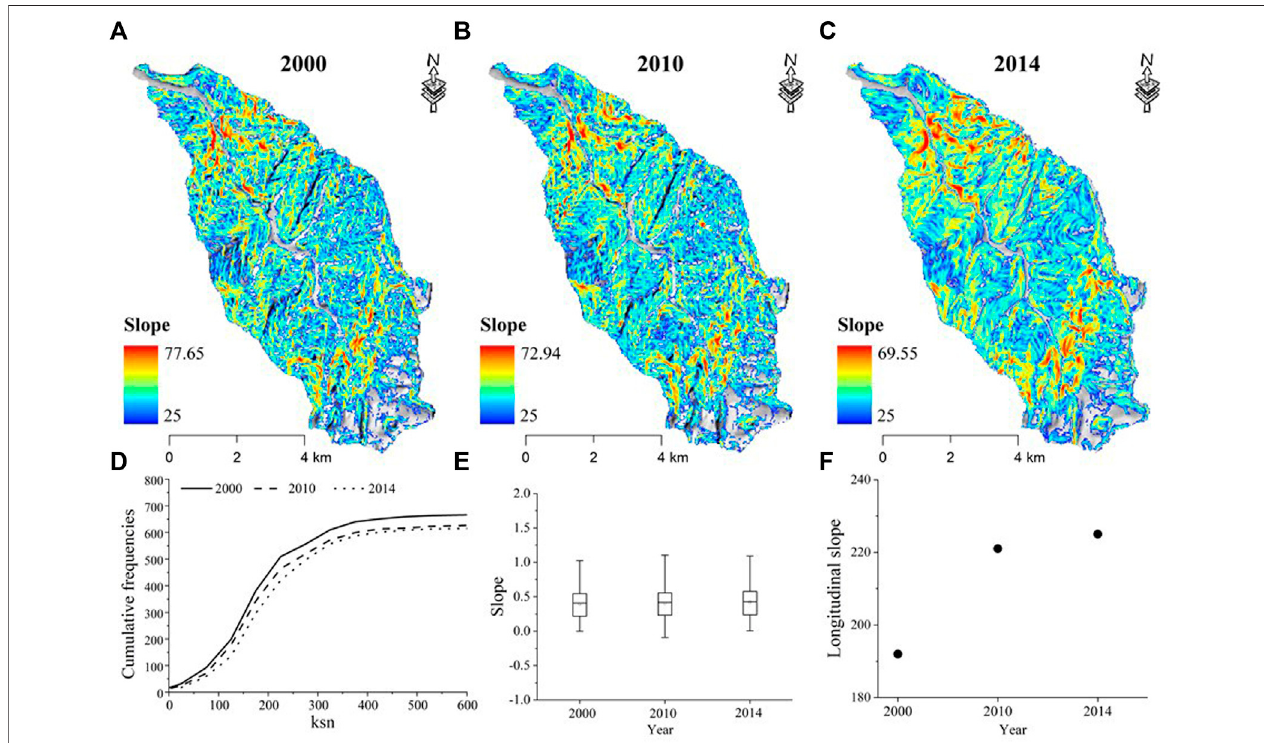
FIGURE 7 | Topographic variation in response to the earthquake (A – C) Slope variation in 2000, 2008, and 2014, respectively. (D) Channel steepness index variation in the Qipangou catchment. (E) Average slope of the main channel in 2000, 2010, and 2014. (F) Main stream longitudinal slope gradient in 2000, 2010, and 2014.